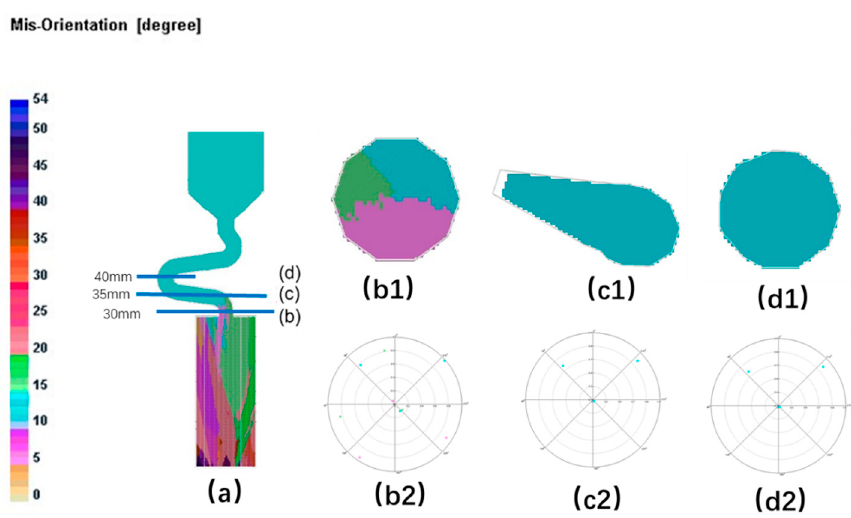
Figure 18. Simulation structure of Z 1 (15°) ( a ); EBSD maps of the grain structure evolution ( b1 , c1 , d1 ) and the EBSD inverse pole figures ( b2 , c2 , d2 ).